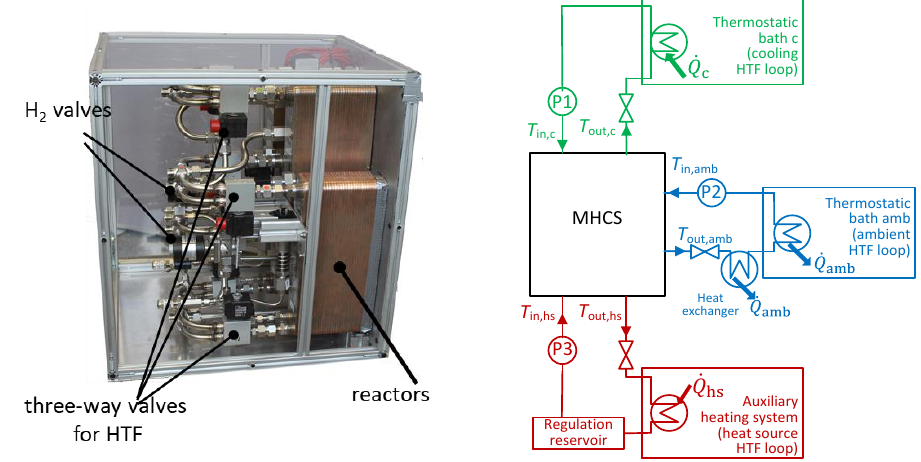
Figure 5. Picture of the realized modular MHCS (left) and schematic flow diagram of the testing infrastructure (right). infrastructure ( right